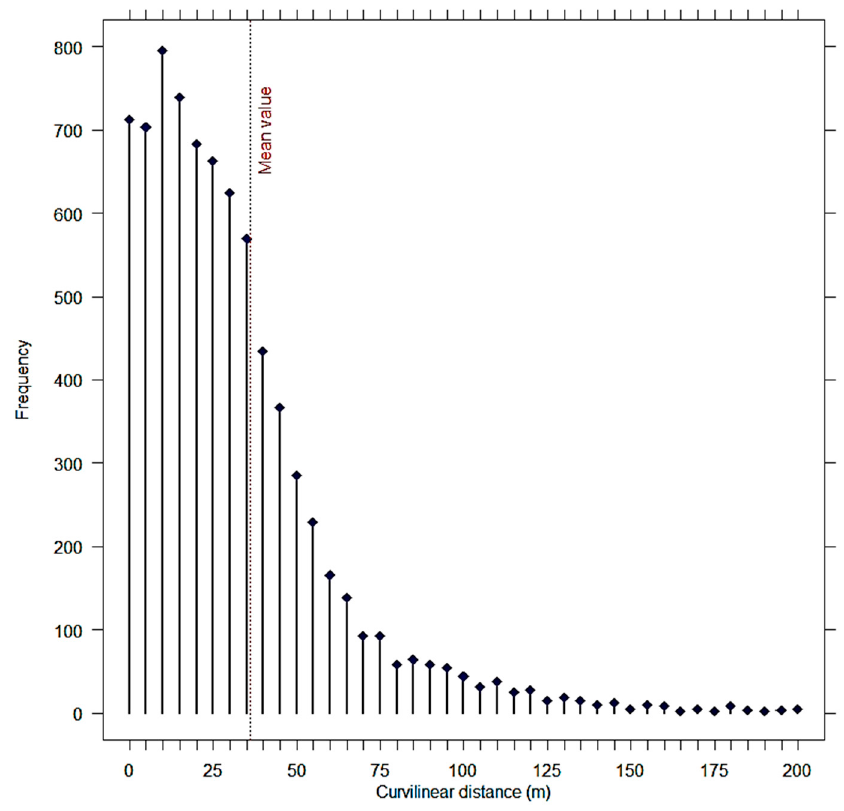
Figure 8. Distribution of the curvilinear distance of the operations.